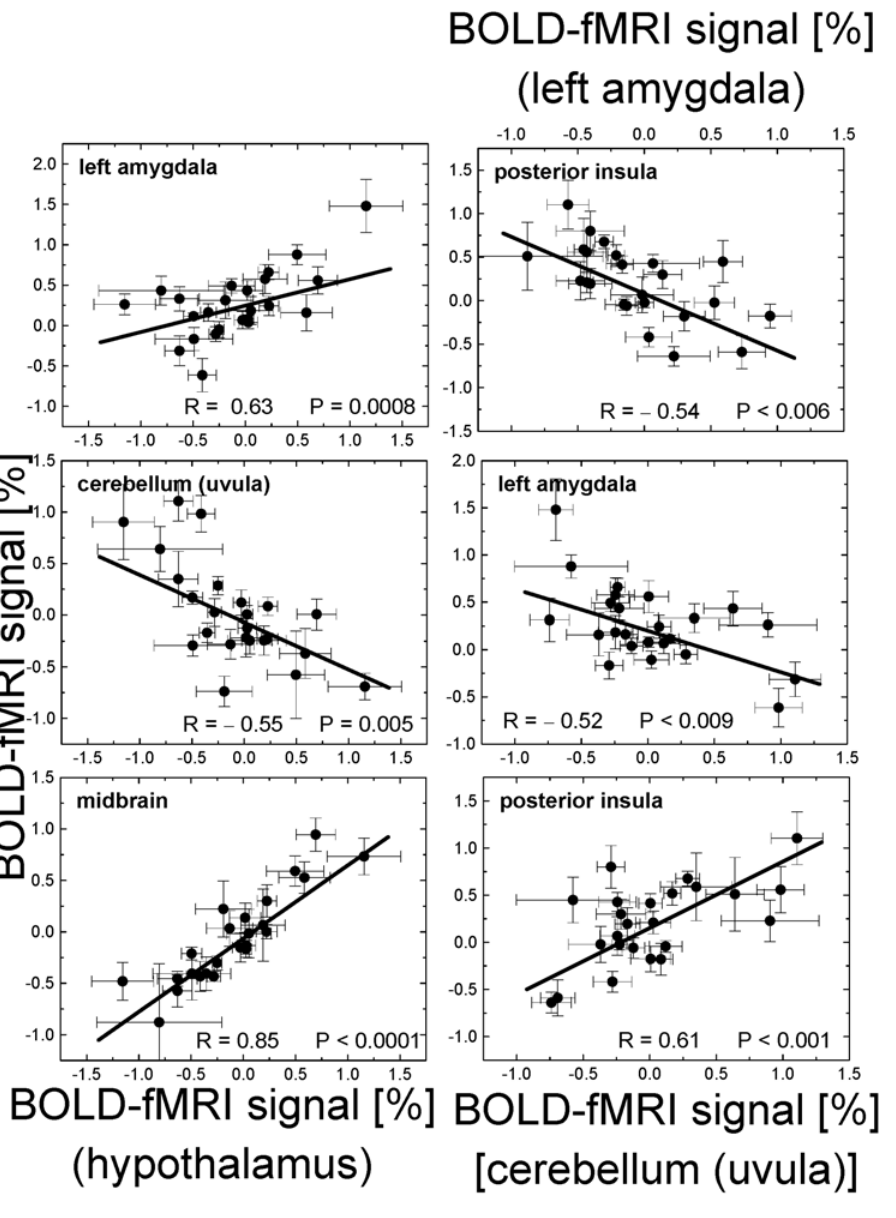
Figure 6. Association of BOLD signals in hyper- and hypo-activated regions. Regression plots exemplifying positive and negative cross- correlations of BOLD-fMRI signals (averaged across all volumetric conditions; 125, 375, 500, 600, and 700 ml) in different ROIs (listed in Table 1). Sample=24 subjects.